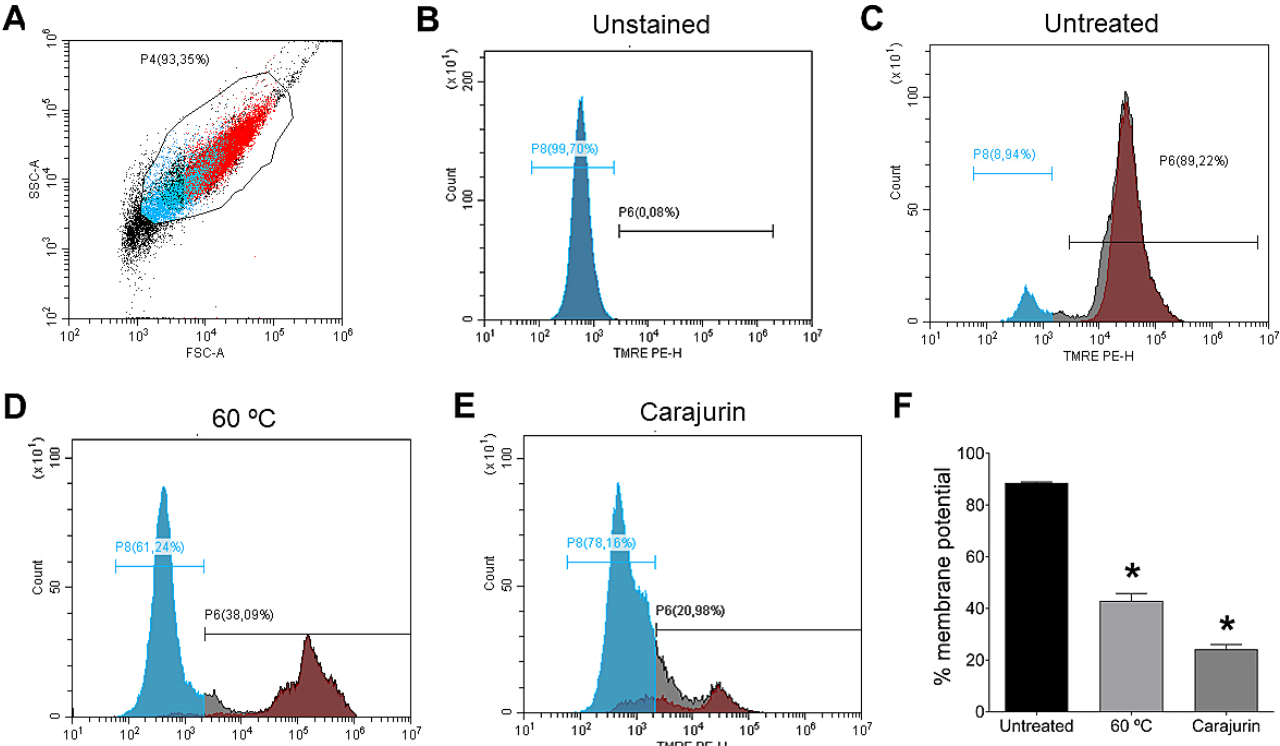
Figure 4. Flow cytometry of Leishmania amazonensis treated with IC 50 of carajurin to assess the potential of the mitochondrial membrane ( ∆Ψ m). ( A ) Promastigotes captured in the gated region and representative histogram. ( B ) Unstained parasites. ( C ) Untreated parasites. ( D ) Promastigote forms of L. amazonensis killed by heat. ( E ) Histogram representative of promastigotes treated with carajurin. ( F ) Statistically significant differences were observed between the percentages of cells marked with TMRE in the untreated group and the groups treated with carajurin, at the IC 50 concentration (26.4 µ M). (*) p < 0.05, when compared with the untreated group by Mann-Whitney